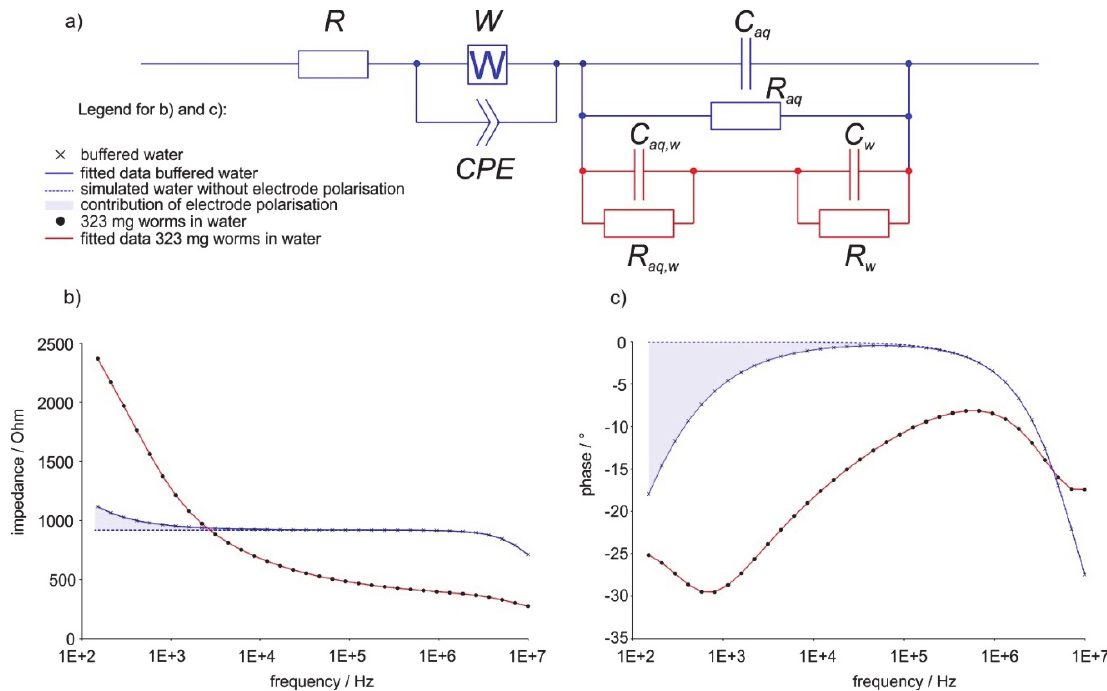
Fig. 1: Equivalent circuit (a), exemplary impedance (b) and phase spectra (c) of tap water and worm biomass in tap water, incl. fitting results. R, W and CPE are resistance, Warburg impedance and constant phase element simulating electrode polarization and ion migration; Caq and Raq the capacitance and resistance of buffered tap water when no current runs through the worms; Cw and Rw are capacitance and resistance of the worms, and Caq,w and Raq,w represent capacitance and resistance of the water between worms and